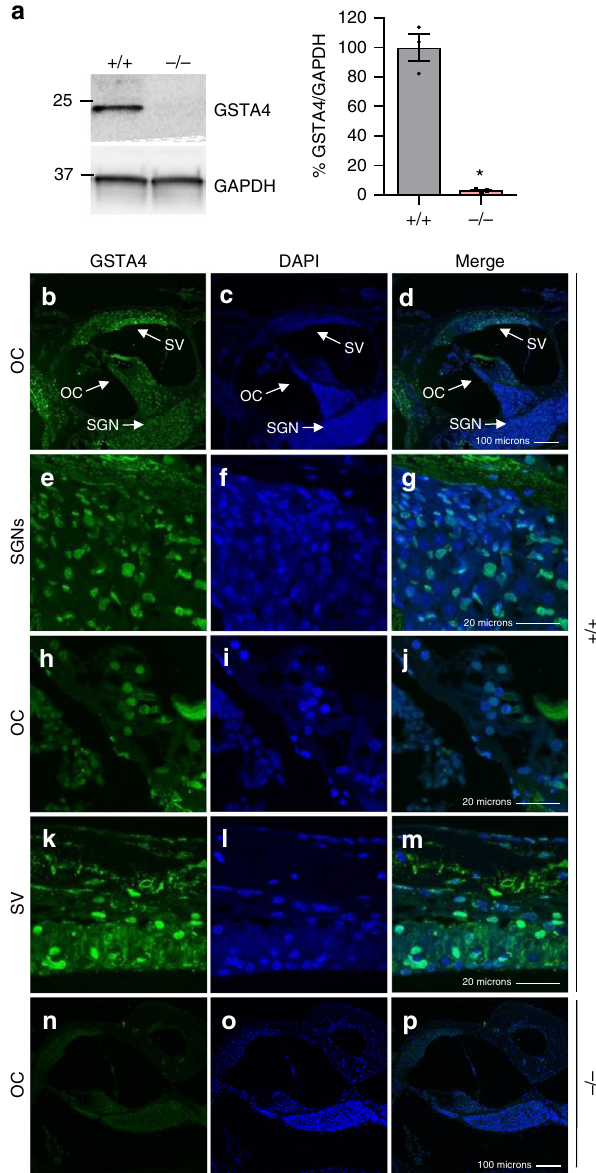
Fig. 1 Localization of GSTA4 protein in mouse cochlea. a Western blot analysis of GSTA4 protein levels in the inner ear from young male Gsta4 + / + and Gsta4 − / − mice. The full-length blot is presented in the Source Data fi le. n = 3, * p < 0.05 vs. + / + (unpaired two-tailed Student ’ s t test). Error bars represent ± s.e.m. b – p GSTA4 staining (green; b , e , h , k , n ), DAPI staining (blue; c , f , i , l , o ), and merged staining ( d , g , j , m , p ) were detected in the organ of Corti regions ( b – d , n – p ), SGNs ( e – g ), organ of Corti ( h – j ), and SVs ( k – m ) from 3-month-old WT ( b – m ) and Gsta4 − / − ( n – p ) males. OC organ of Corti. Scale bar = 100 μ m ( d , p ) or 20 μ m ( g , j , m